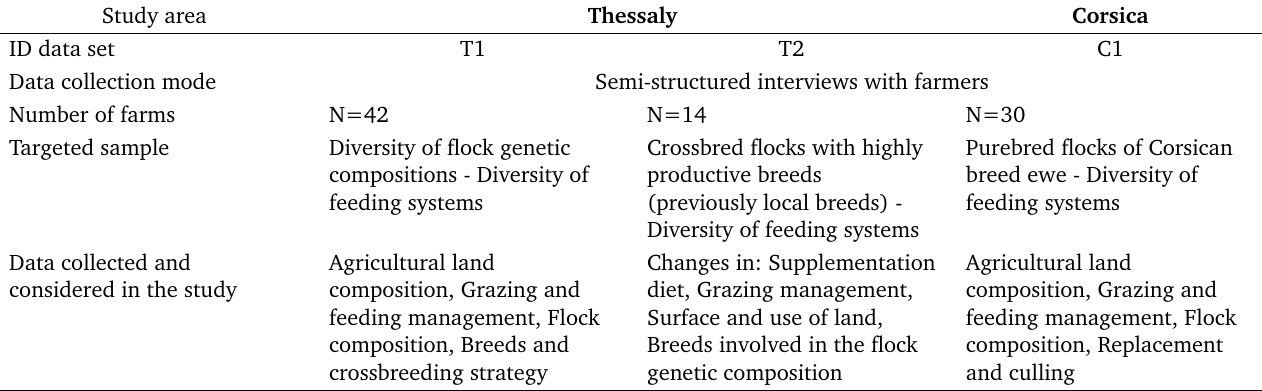
Table 1. Characteristics of data collected in this